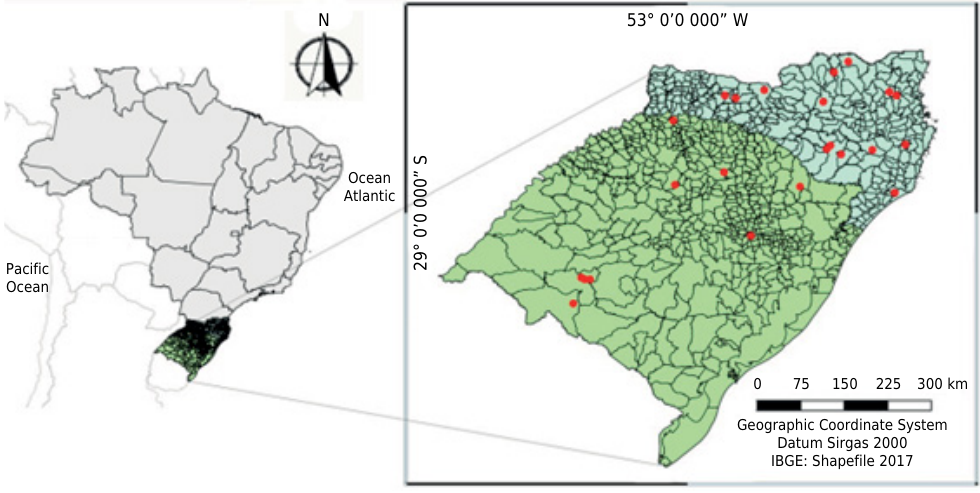
Figure 1. Localization of the 23 sampled soils distributed in the Rio Grande do Sul and Santa Catarina states, Southern